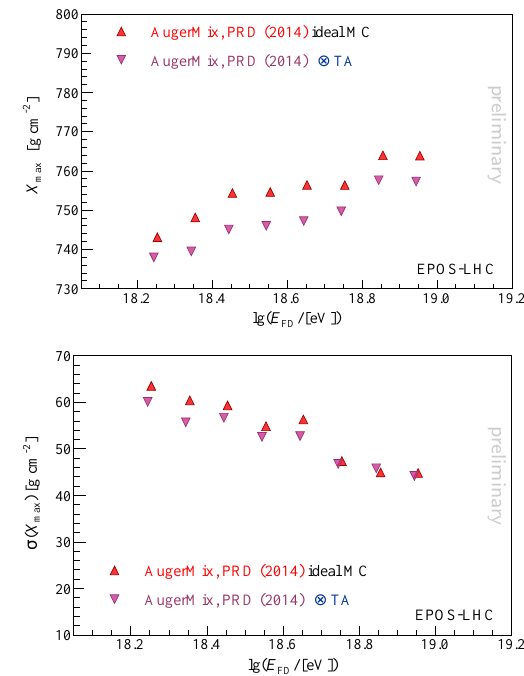
Figure 6. Comparison of (cid:104) X and EPOS-LHC (bottom) [9].